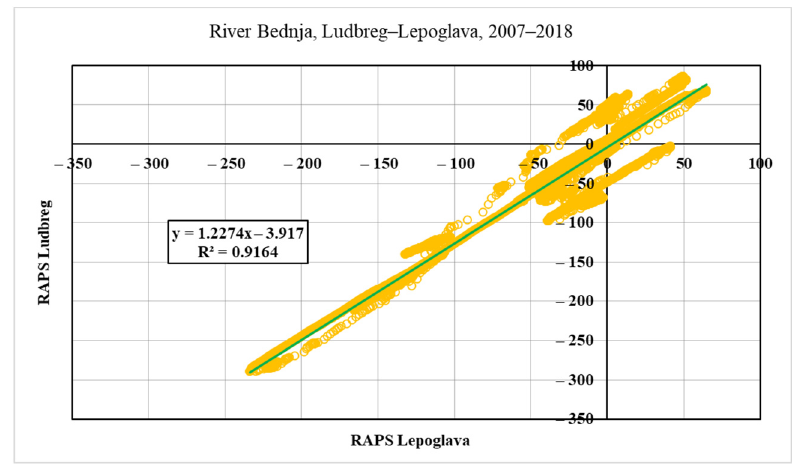
Figure 20. Correlation of RAPS values on Ludbreg and Lepoglava measurement stations.